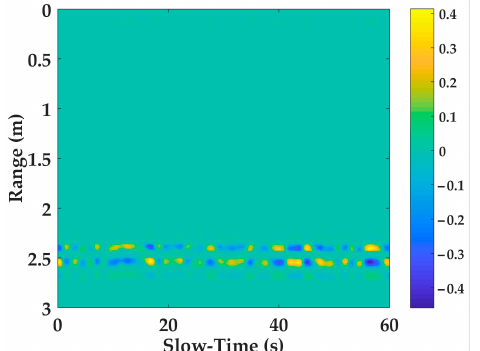
Figure 4. Data after preprocessing DataAF ( x , n ) when the human target is 2.5 m behind the wall. The scope of the target’s movements is not just fixed in one point along the range dimension, because the obtained reflected signals are due to the target’s skin and internal organ movements or movements in other parts of the body.